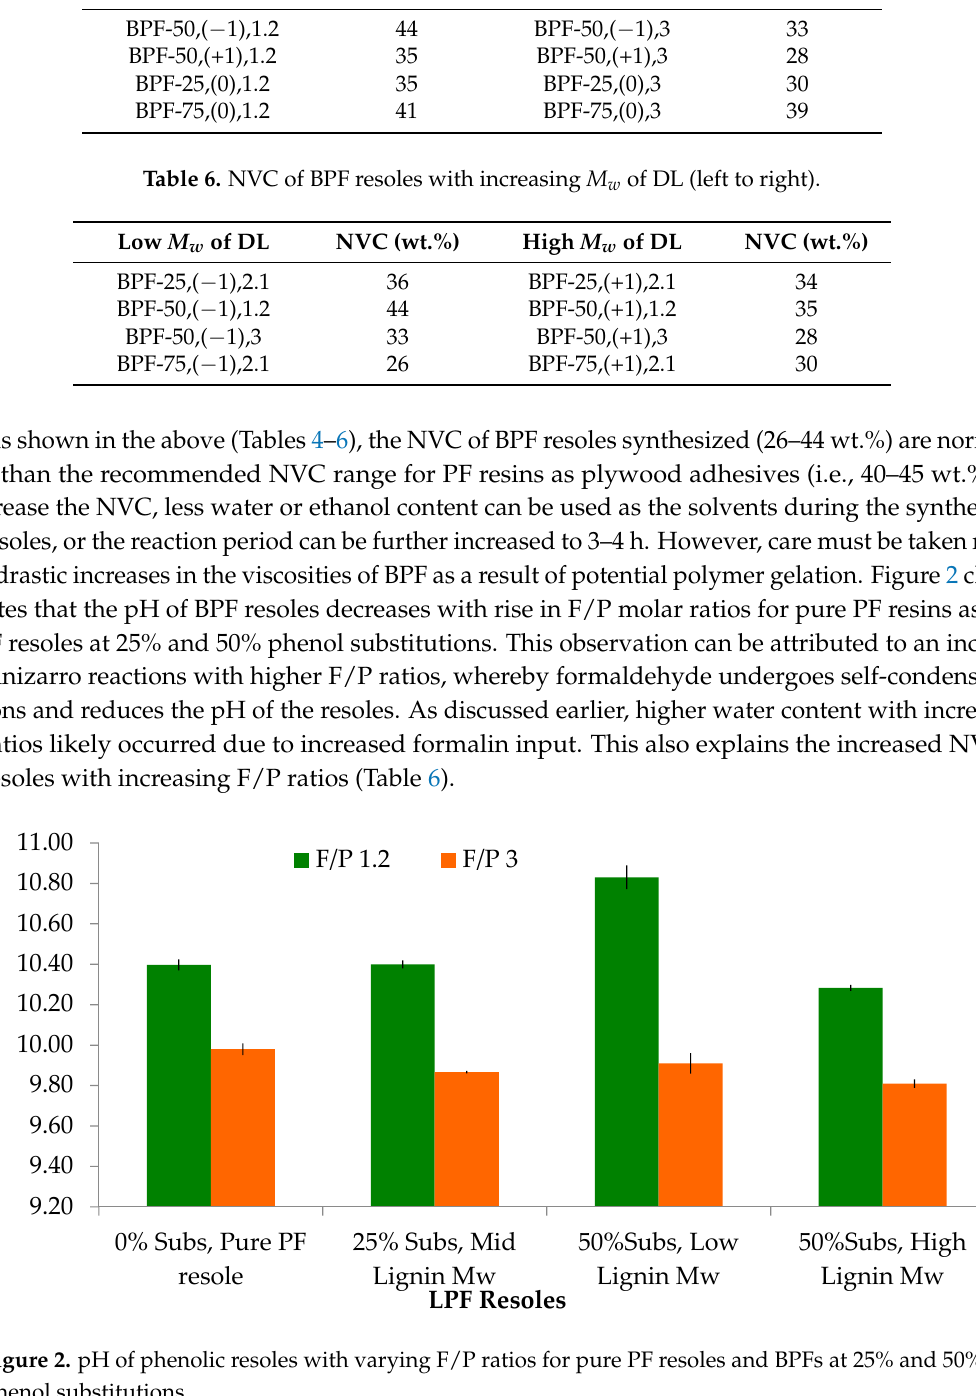
Figure 3. Effects of lignin molecular weight on curing temperature of the BPF Resins at 25% phenol substitution.